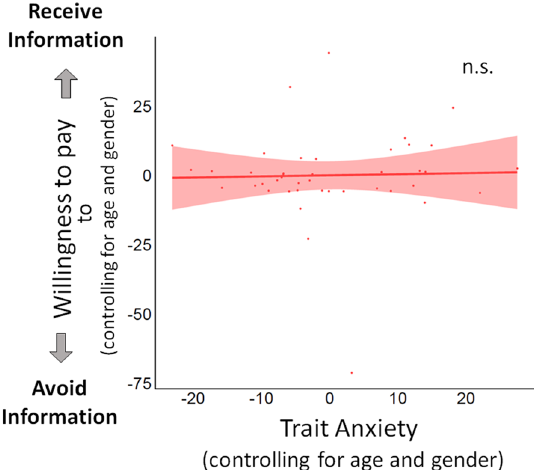
Figure 3. Trait anxiety was not related to willingness to pay for information (Study 2a). Plotted is the partial linear regression predicting WTP (in pence, coded positively if participants indicated they wanted to receive information and negatively if they wanted to avoid information) from trait anxiety (State-Trait Anxiety Inventory), controlling for age and gender (p = 0.863). Results did not change when removing the one outlier. Also note that plotted values are residuals after controlling for age and gender, hence the negative trait anxiety